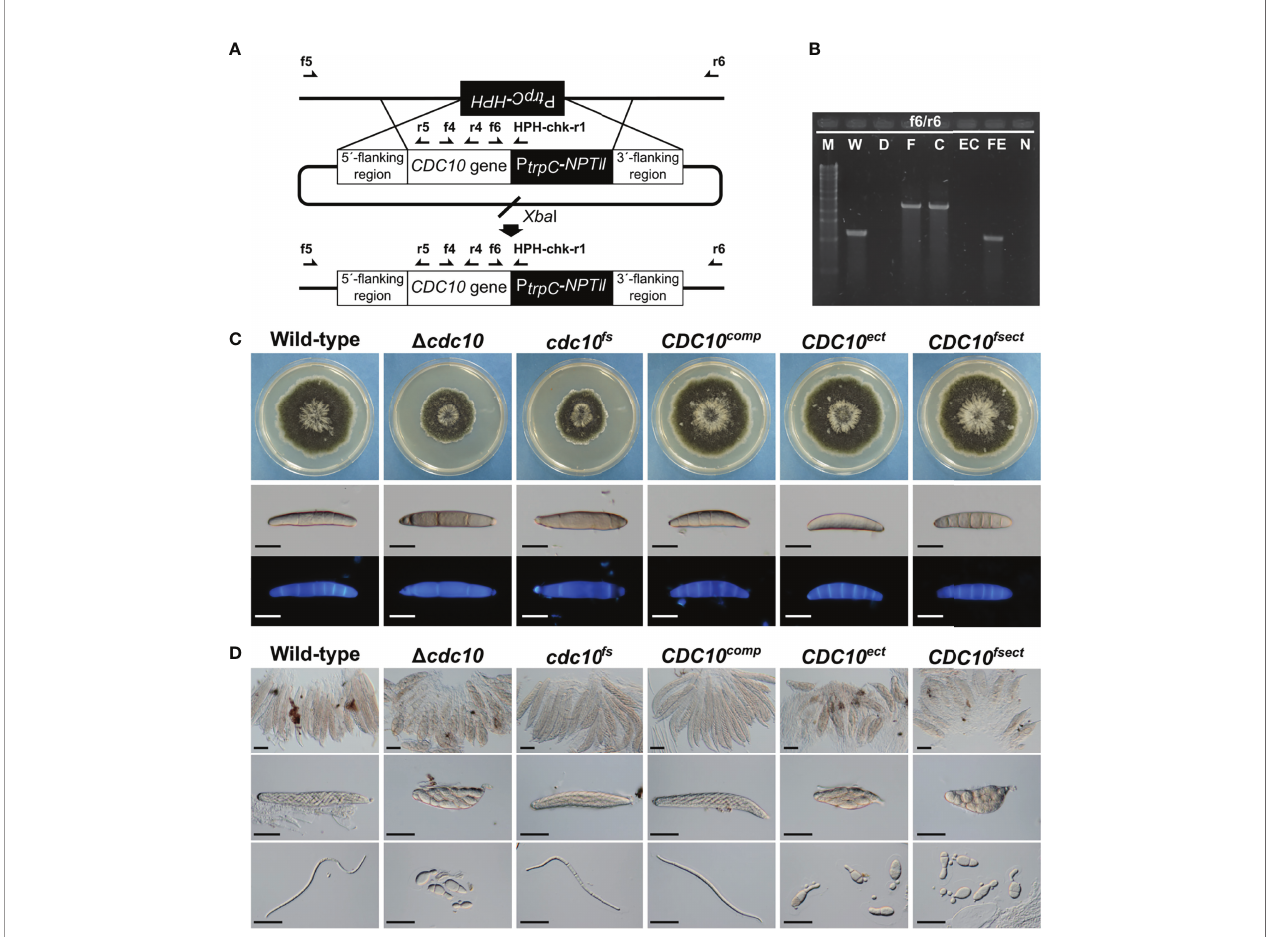
FIGURE 2 | Generation and phenotype of mutants by the insertion of a CDC10 sequence. (A) Schematic illustration of the introduction of linearized pZGCDC10c and the location of primers. The CDC10 comp and the cdc10 fs were generated by the insertion of each cassette into the D cdc10 allele of the D cdc10 strain. (B) PCR results for con fi rmation of the introduction of each CDC10 cassette. Products were ampli fi ed by the primer set f6/r6 (W and WE: 1104 bp; F and C: 2321 bp). M, l / Sty I digest; W, wild type; D, null mutant; F, cdc10 fs ; C, CDC10 comp ; EC, CDC10 ect ; FE, CDC10 fsect ; N, negative control (TE buffer). (C) Colonial growth and conidial morphology of the wild-type strain, the D cdc10 strain, the cdc10 fs strain, the CDC10 comp strain, the CDC10 ect strain, and the CDC10 fsect strain. Each strain was cultured on CV8A for 7 days. Conidia of each strain were harvested from a colony of each strain on CV8A and stained with CFW. Bars : 50 µm. (D) Morphology of ascospores. Each strain was crossed with the wild-type strain on Sachs media. Bars : 50